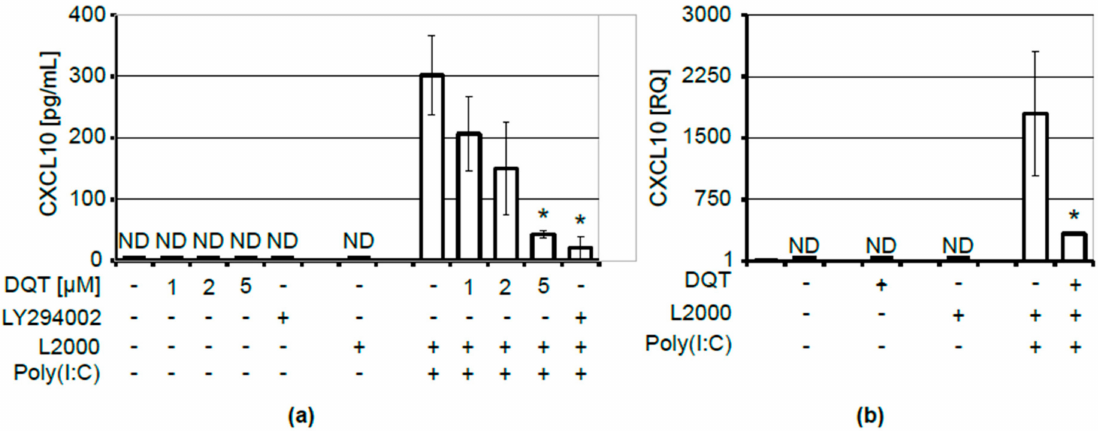
Figure 2. DQT compound inhibits the poly(I:C)-induced production of CXCL10 at the transcriptional level; ( a ) CXCL10 protein levels in cell culture media after 24 h of transfection with 0.2 µ g of poly(I:C) using Lipofectamine 2000 (L2000) and subsequent DQT or 25 µ M LY294002 treatment; mean values and standard deviation of three independent experiments are shown; the results below showing the sensitivity range of the ELISA assay are marked as ND (not detected); statistical significance is marked with asterisks; ( b ) relative quantification of CXCL10 mRNA expression assayed by real-time RT-PCR in conditions described in ( a ); for inhibition of CXCL10 mRNA expression, cells were treated with 5 µ M DQT; mean values and standard deviations of two individual experiments are